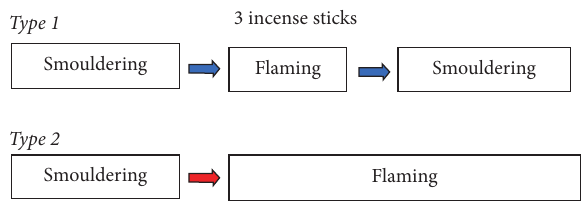
Figure 8: Schematic analysis of transition in smoldering combus- tion for 3 incense